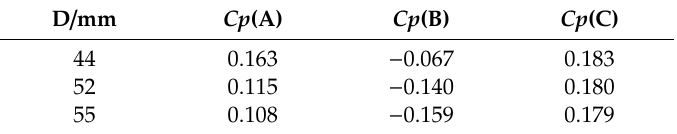
(D = 44 mm / 52 mm / 55 mm, Ma = 0.75, α = 0 ◦ . The position of point A / B / C is shown in Figure